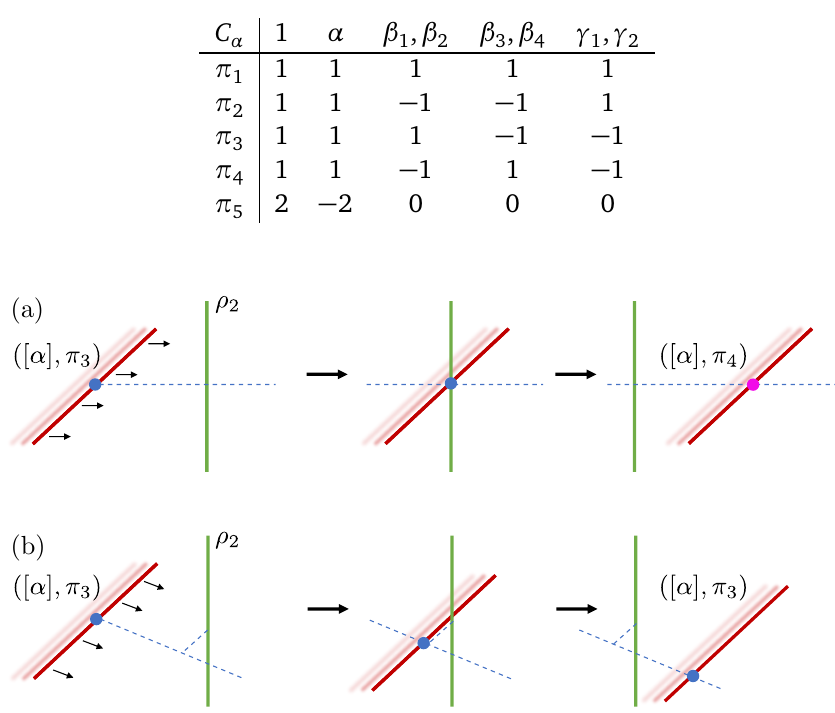
Table 5: The character table of the centralizer subgroup C α .